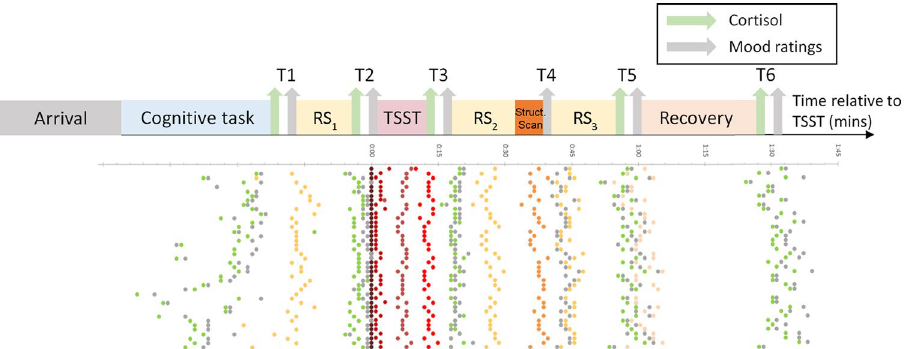
Figure 1. Schematic diagram of experimental protocol. Cortisol and subjective mood ratings were collected at 6 time points, and the main section of the protocol consisted of 3 resting-state fMRI scans, with administration of the Trier Social Stress Test (TSST) between scans 1 and 2. Each row of dots represents a single participant, and the time that they began each stage of the procedure relative to